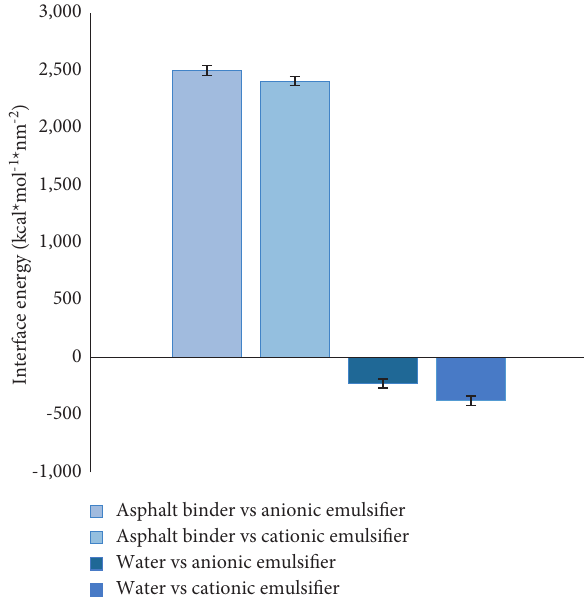
Figure 5: The interface energy results of the